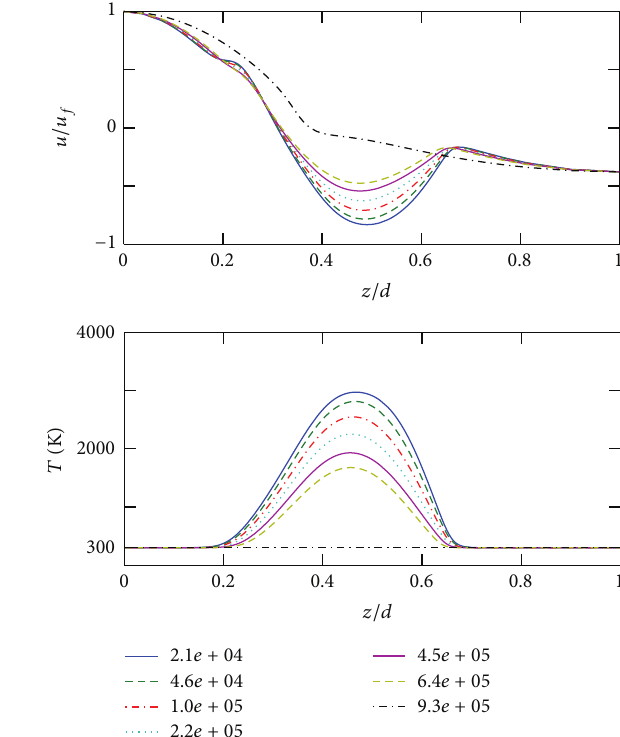
Figure 3: Profiles of the normalized axial velocity 𝑢/𝑢 𝑓 and the temperature 𝑇 over the normalized grid 𝑧/𝑑 for selected maximum strain rates [1/s] of the hydrogen-oxygen flame. The operating pressure is 1 bar.